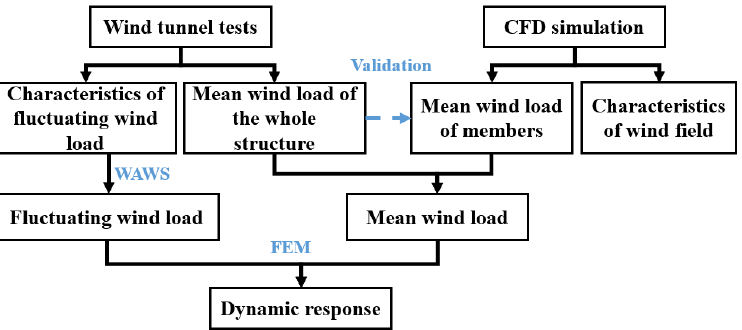
Figure 1. Process of calculating the wind-induced response.